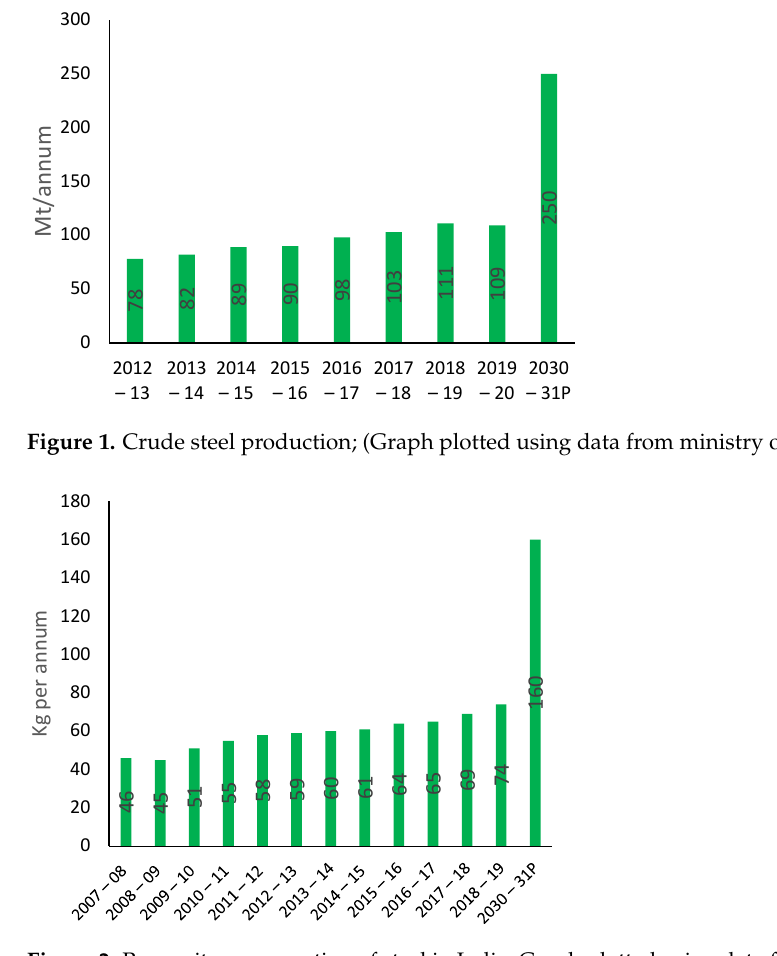
Figure 2. Per capita consumption of steel in India; Graph plotted using data from India Brand Equity Foundation [4]).